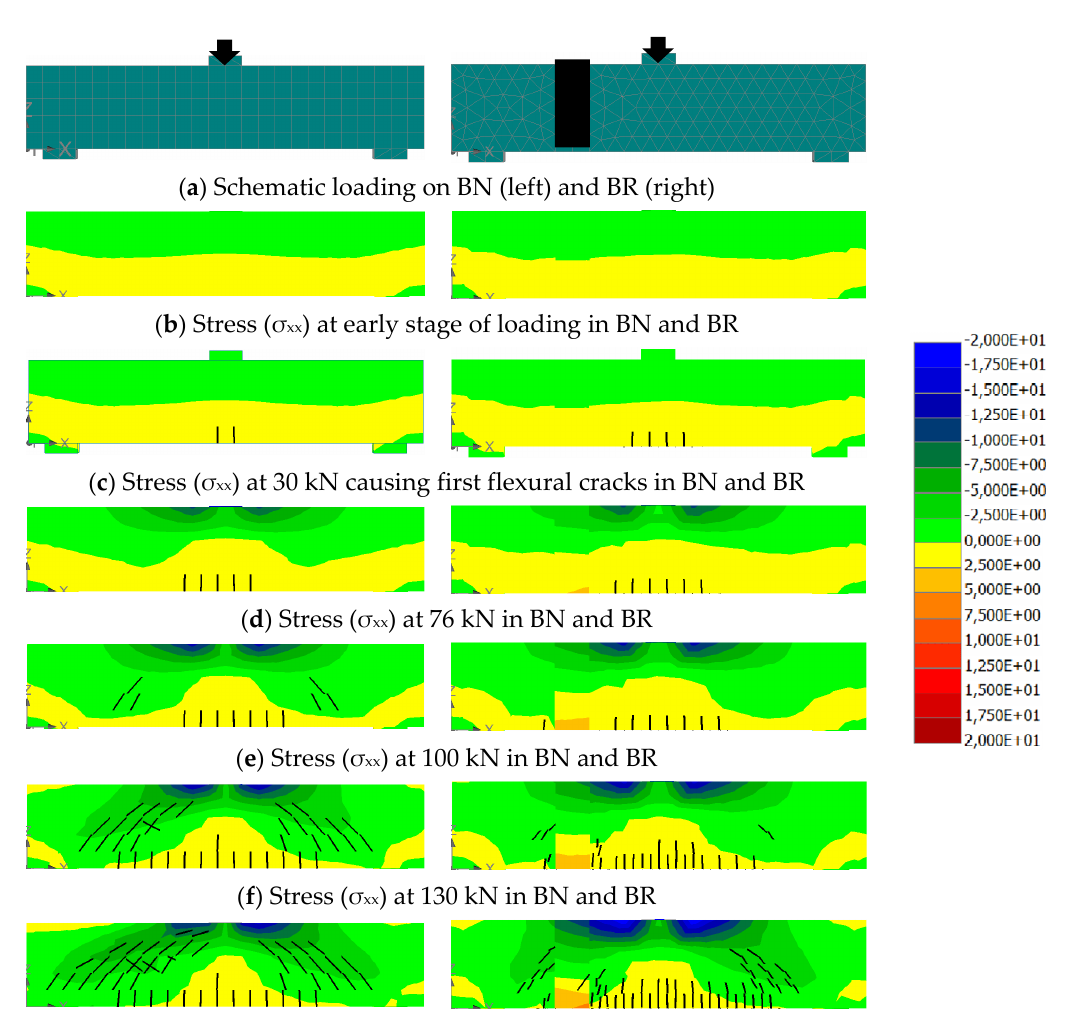
Figure 8. Normal stress ( σ xx ) distribution and cracks formation at various stages of loading.